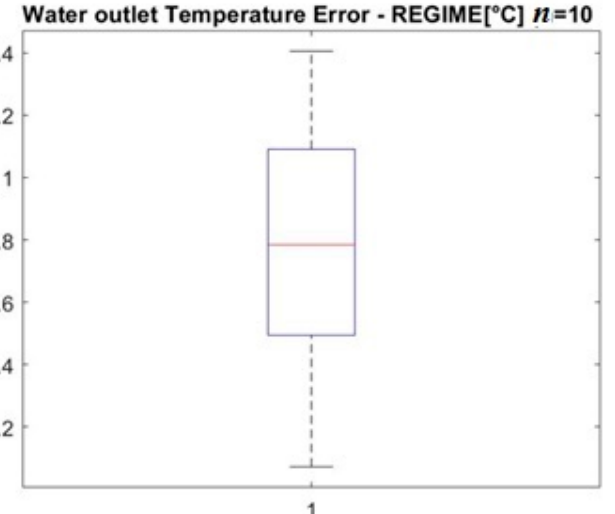
Figure 21. Water outlet temperature (in regime conditions) error blockplot diagram for a number of sections n = 10.